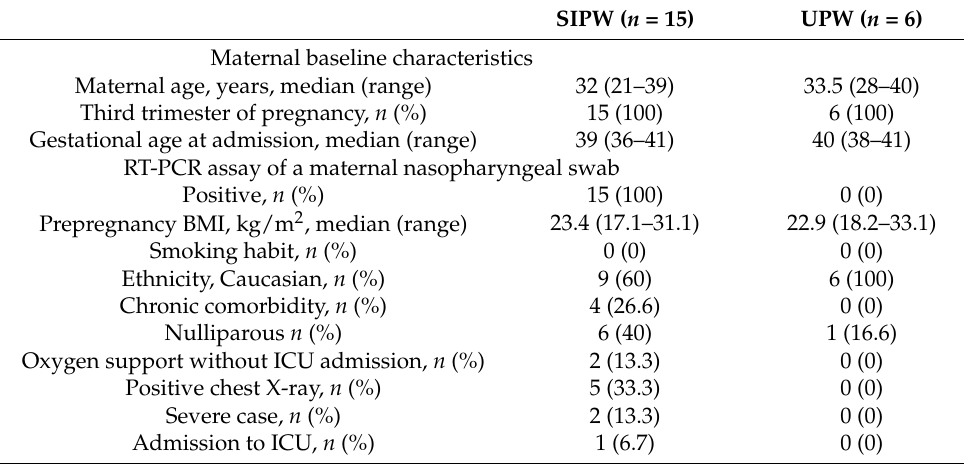
Table 1. Baseline characteristics of the study population on